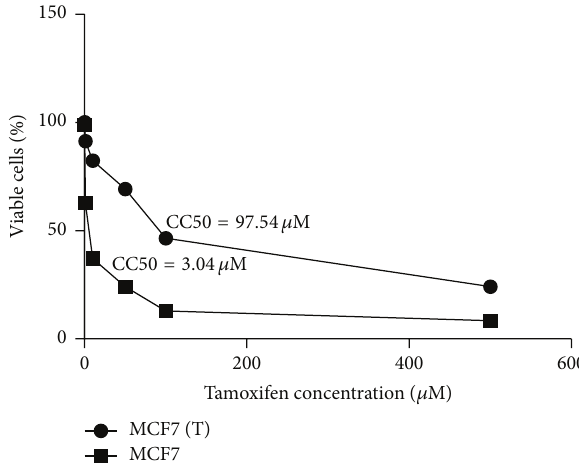
Figure 2: Percentage of viable cells over control (DMSO) after treatment with tamoxifen 1 𝜇 M or DMSO.